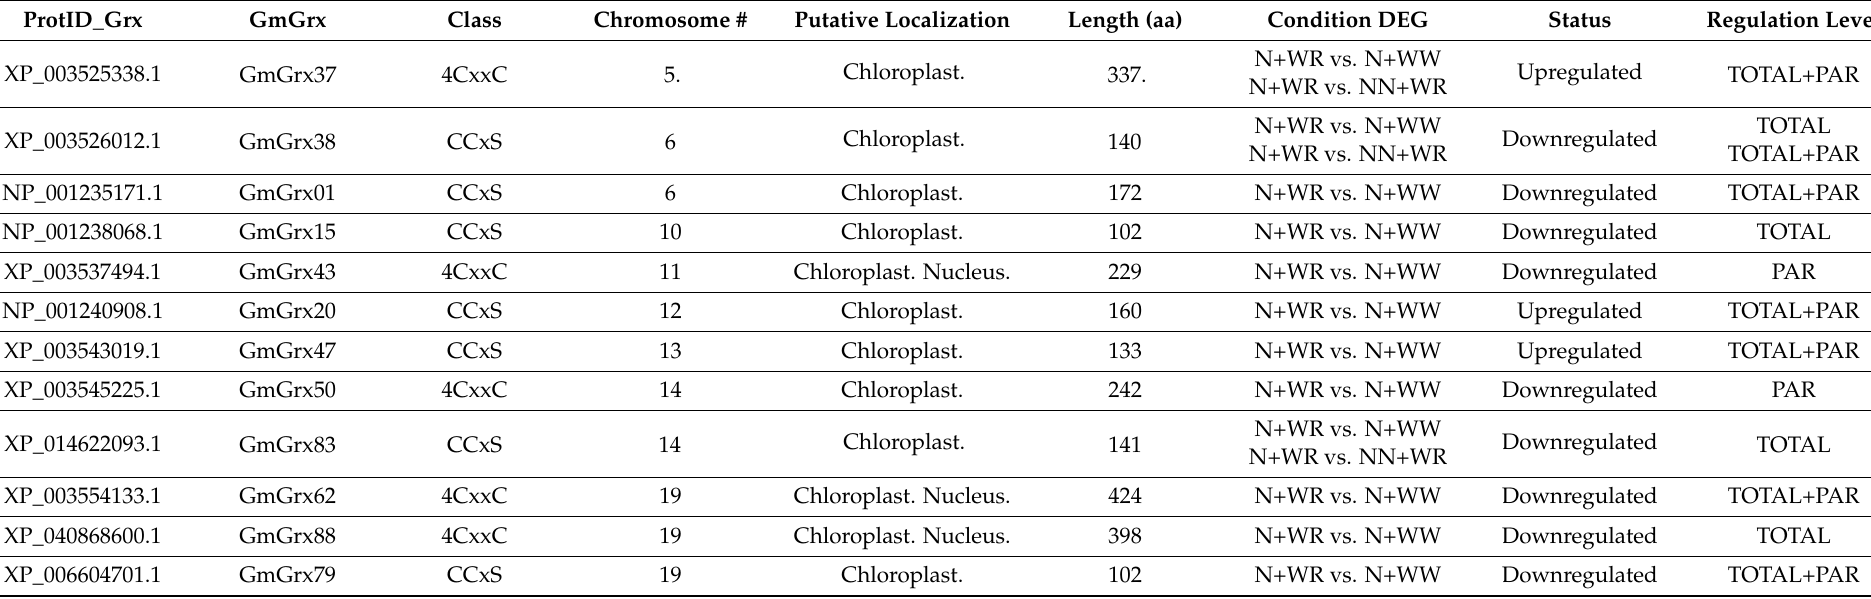
Table 2. Differentially expressed GmGrx in nodulated and water-restricted plants. The class, chromosome localization, subcellular putative localization, and protein length are shown. The contrast (N+WR vs. N+WW and/or N+WR vs. NN+WR) in which the DEG condition was achieved together with the status (up- or down-regulated) and the regulation level (TOTAL, PAR, or TOTAL+PAR) are also